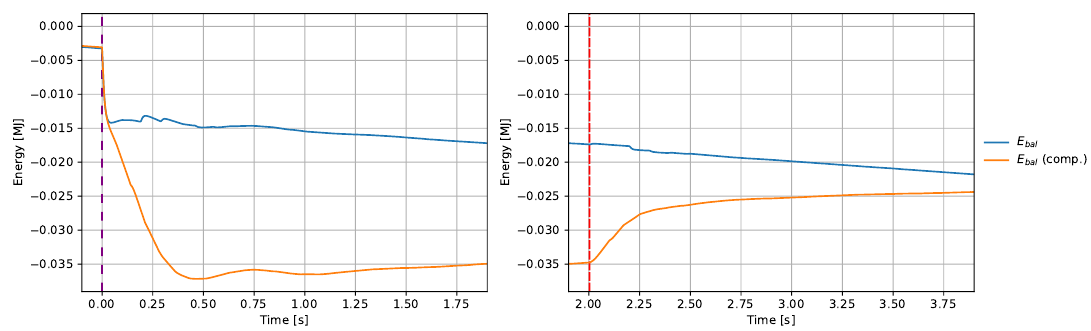
Figure 13. Inset graphs of power change during: DL step ( left ); and OLTC tap change ( right ).